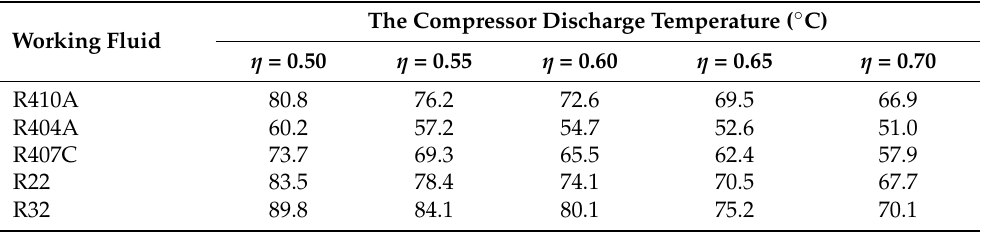
Table 1. The compressor-discharge temperature of air-conditioning system with evaporating and condensing temperatures of 5 ◦ C and 40 ◦ C, respectively